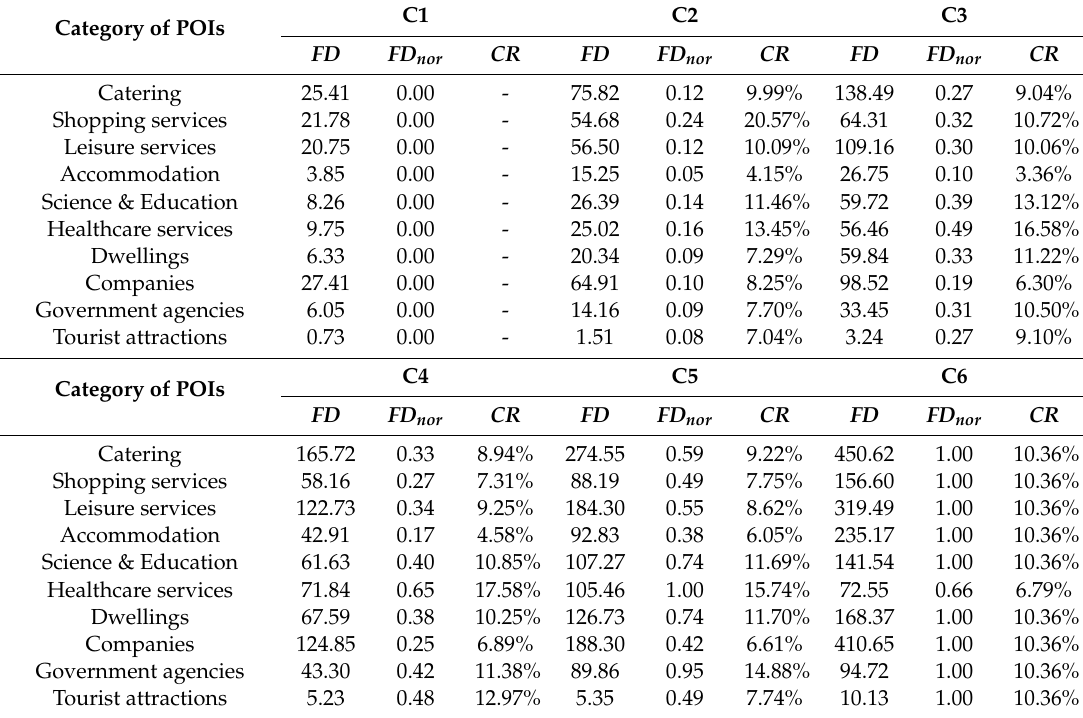
Table 1. POI frequency density and category ratio in di ff erent